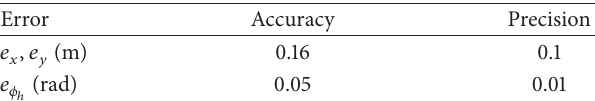
Table 1: Localization system